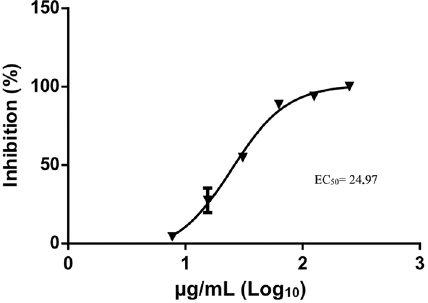
Figure 3. Plaque inhibition analysis of the ethanolic extract of S. sisymbriifolium roots in the virucidal assay. Dengue virus (DENV-2) was treated with 2-fold serial dilutions of the root extract for 1 h. Treated DENV-2 was used to inoculate monolayers of Vero E6 growth in a 24-well plate, which were then incubated for 7 days. The number of plaques in the wells with cells infected with the treated virus was compared with the number of plaques in the wells with cells infected with the untreated virus to determine the percentage of plaque reduction. The 50% maximal effective concentration (EC 50 ) value of the extract was determined by nonlinear regression analysis. The data are reported as means ± SE of quadruplicate wells.